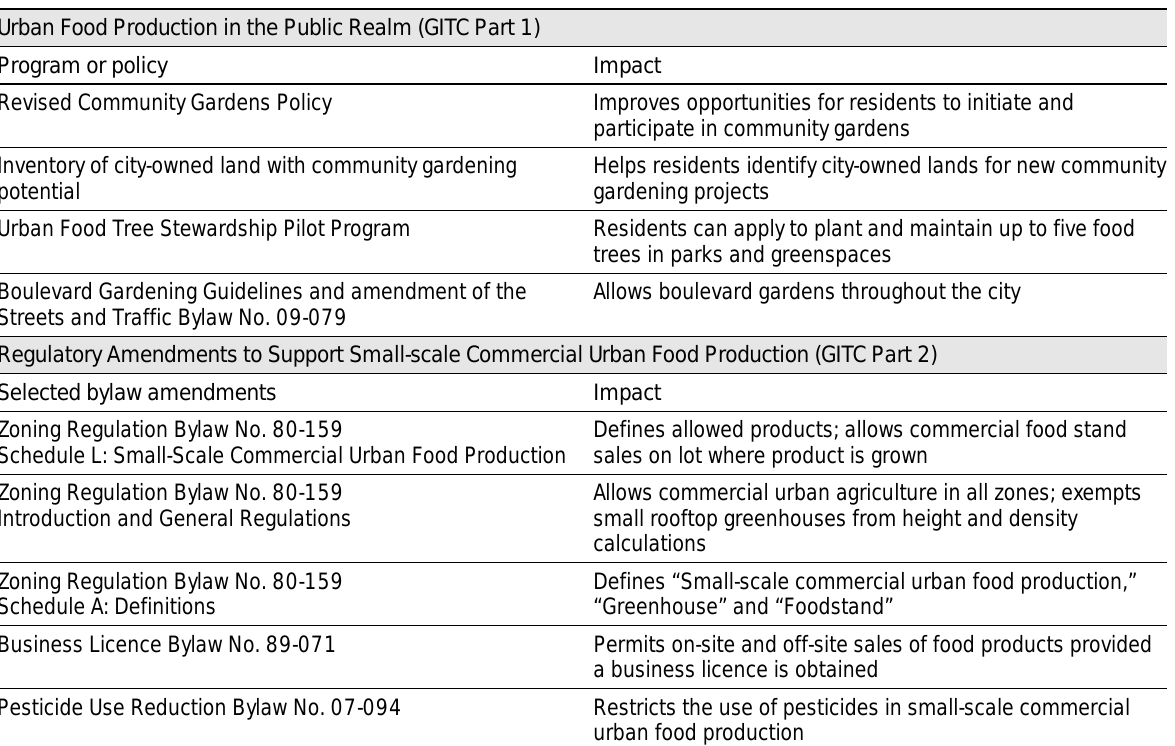
Table 1. Key GITC Policy and Program